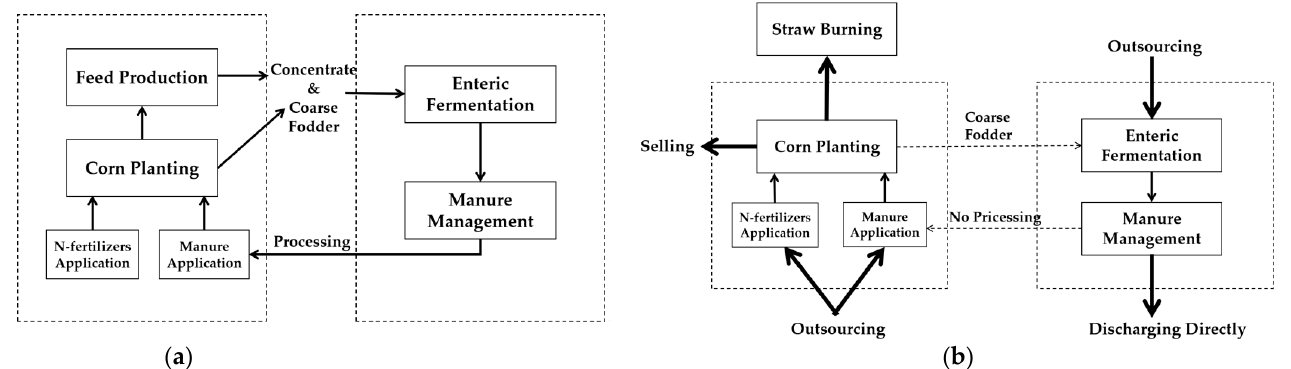
Figure 1. ( a ) The EC model; ( b ) The non-EC model. Note: (1) Each solid line box indicates an independent process, and each dotted line box just indicates that the processes in the box occur in the same place; (2) In ( b ), each thick solid line arrow indicates the largest percentage of resources circulate in that channel, the thin one comes second, and the dotted one is the lowest.